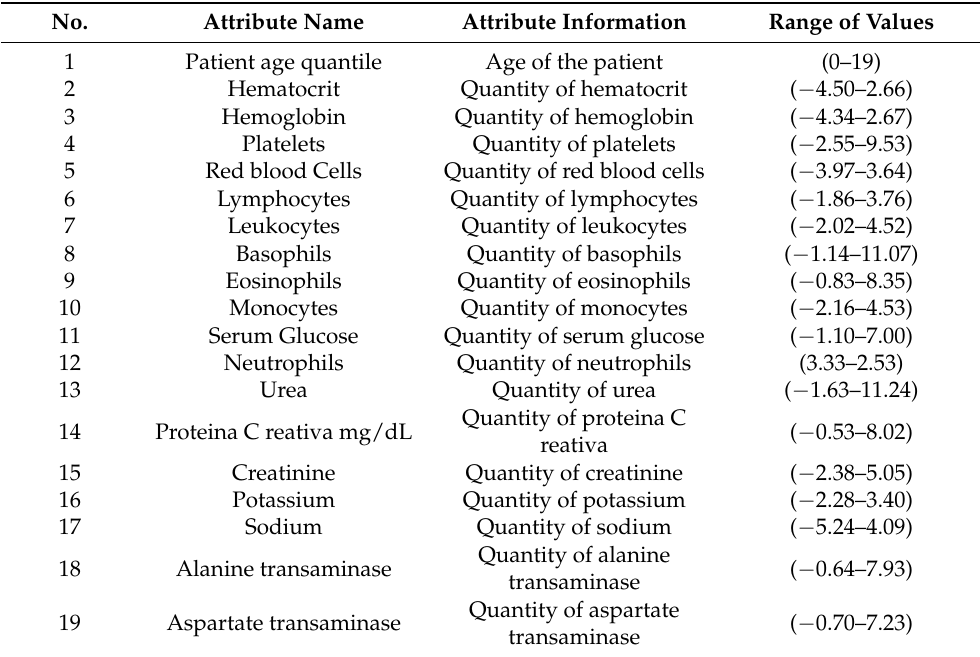
Table 4. Dataset description of